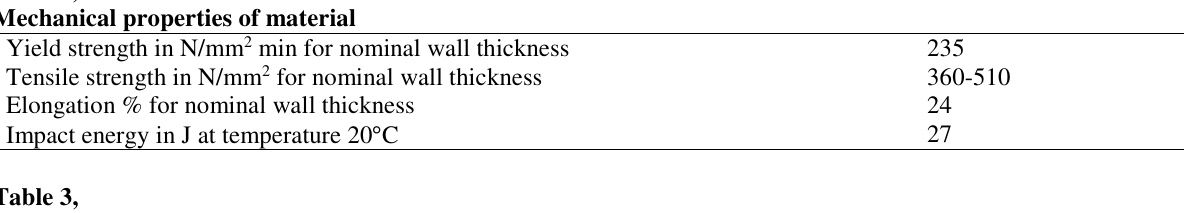
Physical properties of material